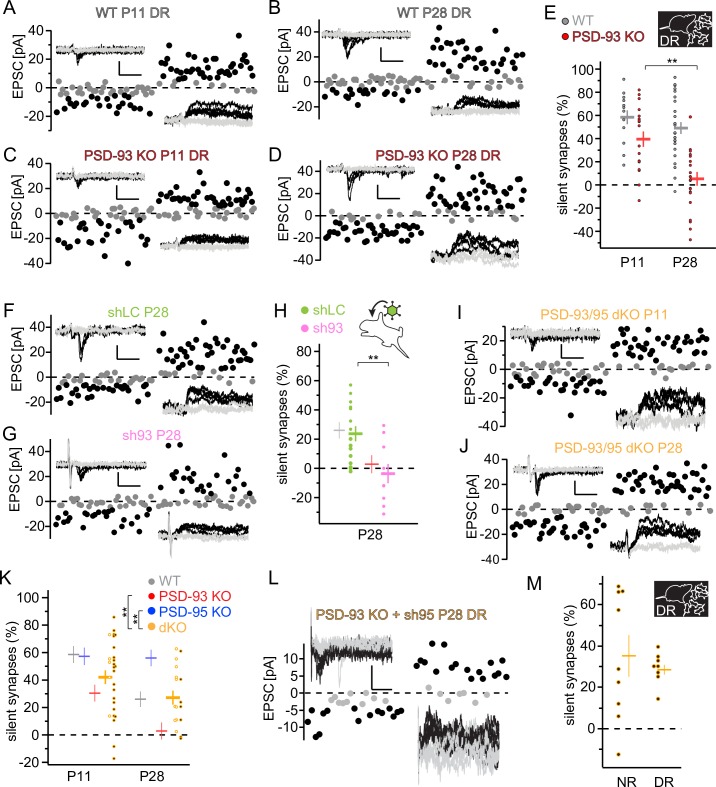
Visual experience and DLG-MAGUK paralogs are required for the developmental decrease of silent synapses.(A-D, F, G, I, J, L) Sample traces of EPSCs using minimal stimulation of L4 afferents of DR WT mice at P11/P28 (A/B), DR PSD-93 KO (93KO) mice at P11/P28 (C/D), P28 WT mice with AAV-shLC/AAV-sh93 (F/G), PSD-93/95 dKO mice at P11/P28 (I/J), or DR at P28. Scale bar: 20 ms and 25 pA. (E, H, K, M) Summary graphs of the fraction of silent synapses of indicated genotypes/manipulation (inset) at indicated developmental time points. Dots represent values of single neurons. (K, M) Values of dKO (orange) and PSD-93 KO with sh95 are presented with white- or black-centered dots, respectively. Values of dKO and PSD-93 with sh95 are pooled for average value (horizontal bar). For comparison, average values from Fig 1 are plotted as thin horizontal bars without dots of individual values (H, K). Statistical difference between individual groups are presented in graphs and between genotypes in inset. Data are displayed as in Fig 1. **p < 0.01. Underlying data for this figure can be found in S1 Data. AAV, adeno-associated viral vector; dKO, double KO; DLG, disc-large; DR, dark-reared; EPSC, excitatory postsynaptic current; KO, knock-out; L4, layer 4; MAGUK, membrane-associated guanylate kinase; NR, normal-reared; P, postnatal day; PSD, postsynaptic density; shLC, short hairpin RNA against luciferase; sh93, short hairpin RNA against PSD-93; sh95, short hairpin RNA against PSD-95; WT, wild-type.